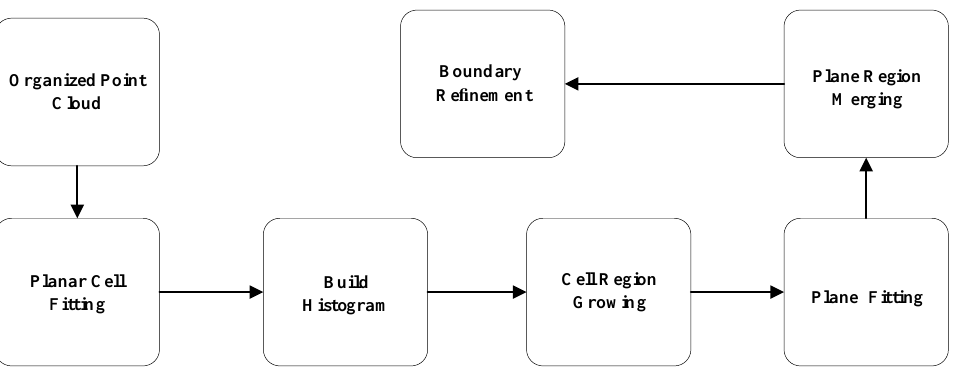
Figure 3. Main flow of planar segmentation